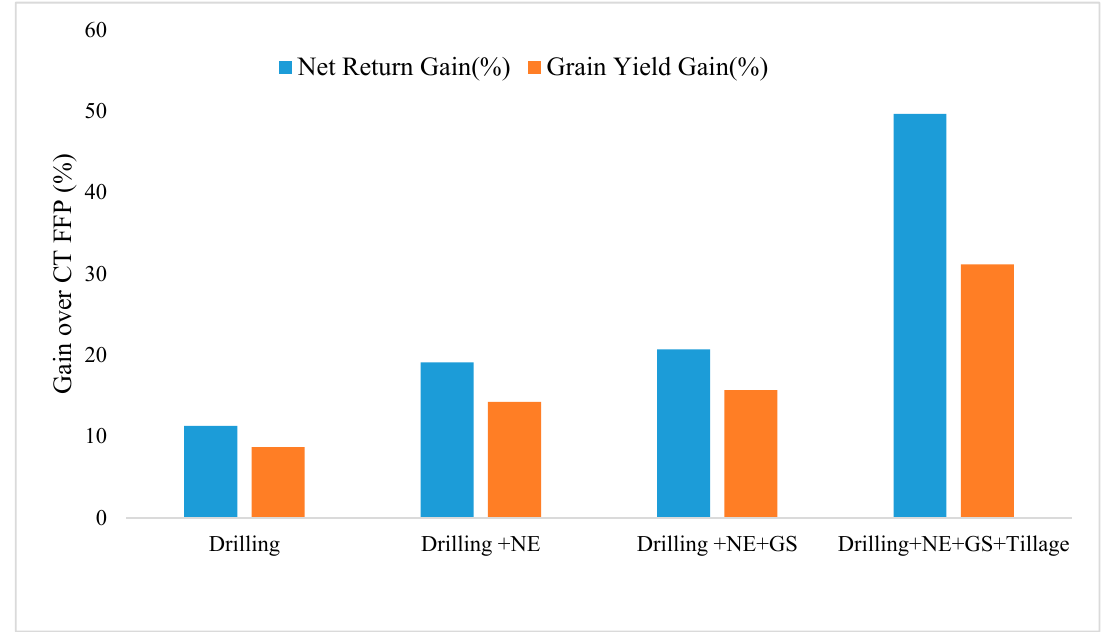
Figure 4. Bar diagram representing the effect of various nutrient management methods and practices on productivity and profitability in maize-wheat system.